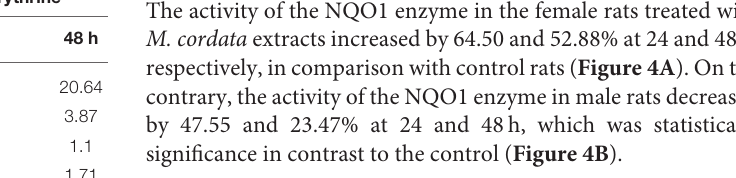
TABLE 4 | The residue result of sanguinarine and chelerythrine in rat tissues (ng/g).